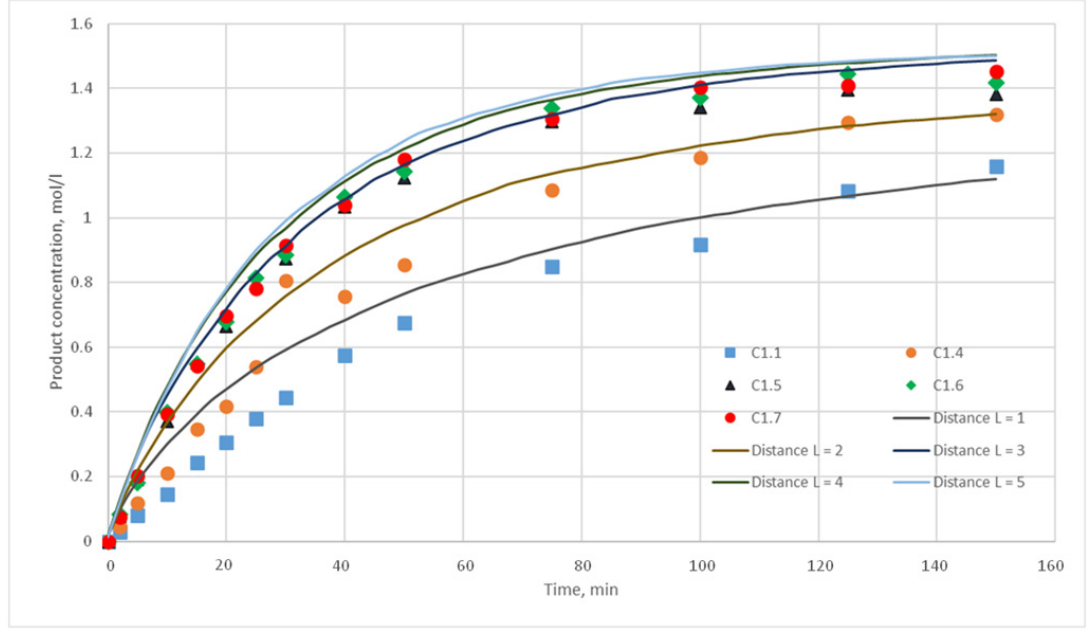
Figure 11. Calculation and experimental reaction kinetic curves. Reaction probability p = 0.025. Lines—calculation curves, points—experimental data.